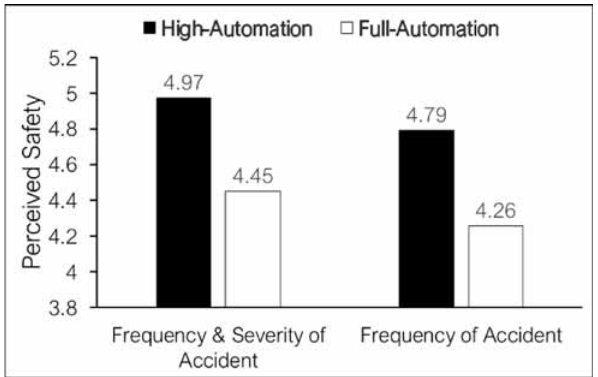
Fig. 1. Perceived safety by automation level and information amount (study 2).